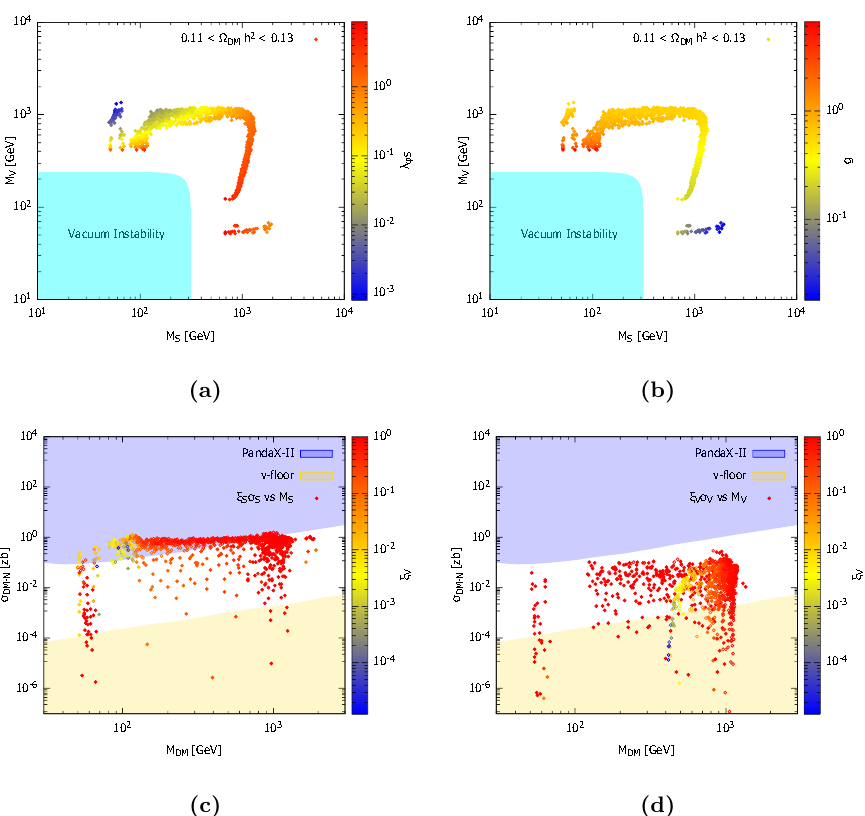
Figure 8. (a) and (b): parameter space consistent with DM Relic density. Cyan region is not allowed because in this region M 2 < 0 (see eq. (2.7)) and we do not have a global vacuum. (c) and ϕ (d): Rescaled DM-Nucleon cross section for the parameter space already constraind by DM relic density. Hollow circles are excluded by direct detection constraint